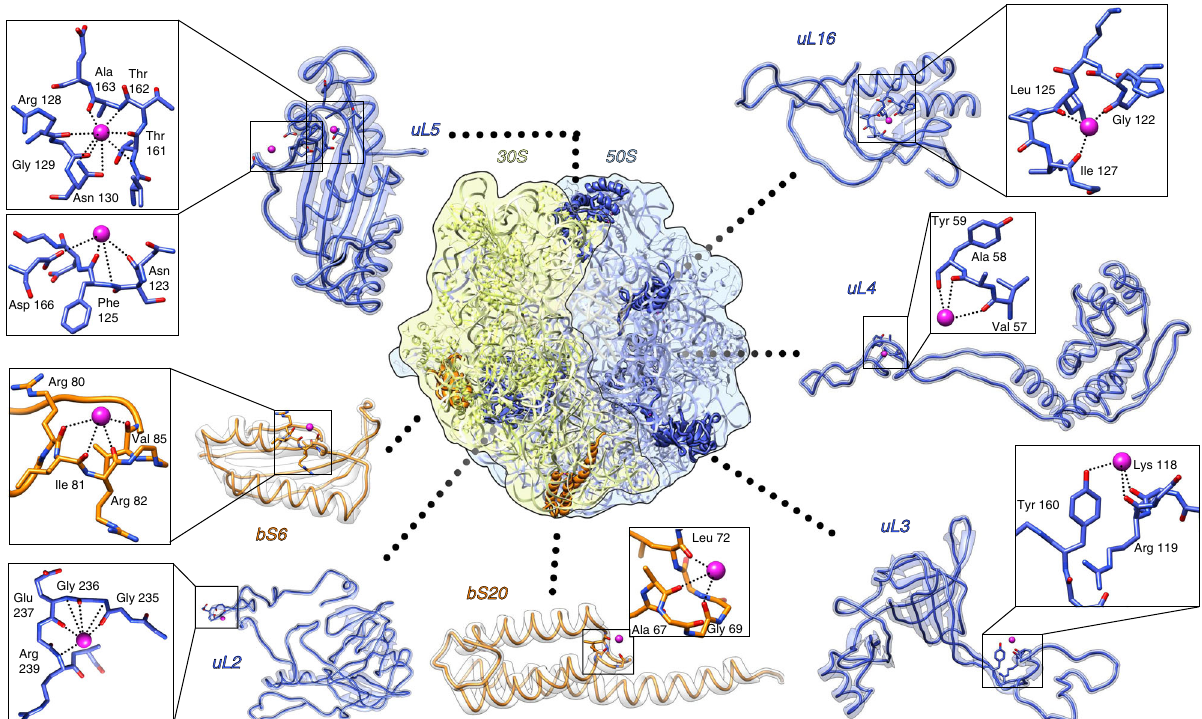
Fig. 6 Interaction of K + ions with the ribosomal proteins from 30S subunit and from 50S subunit. K + ions are shown as magenta spheres, 30S proteins in orange, 50S proteins in